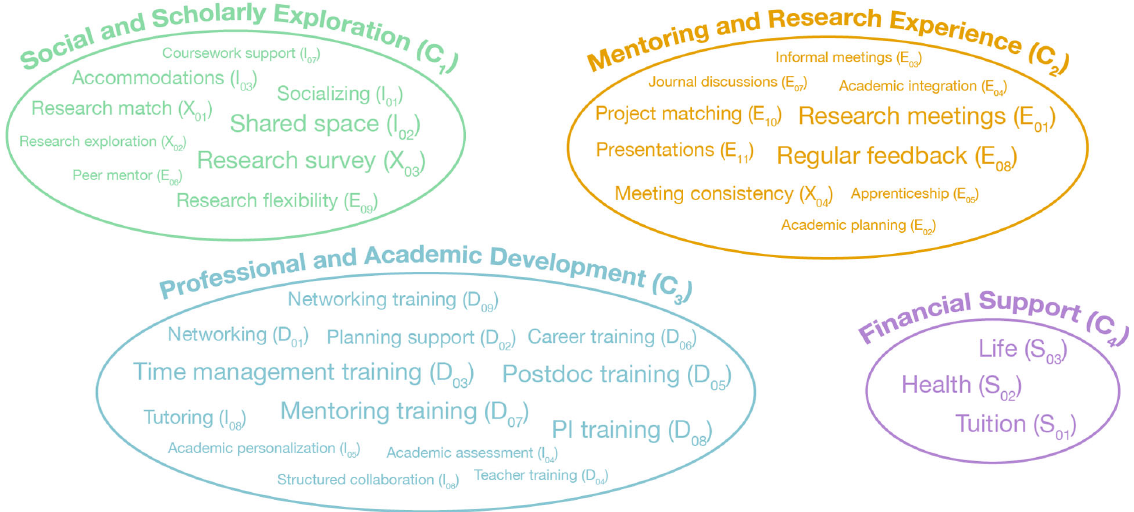
FIG. 5. A visual representation of the four clusters in which each term represents a particular survey item. The colors correspond to those used to shade clusters in Fig. 3: C 1 (green), C 2 (orange), C 3 (teal), or C 4 (purple). The font size of each term reflects the relative importance of that survey item to the respective cluster, as determined by the hierarchical clustering shown in Fig. 4. Complete definitions of the items are presented in Table